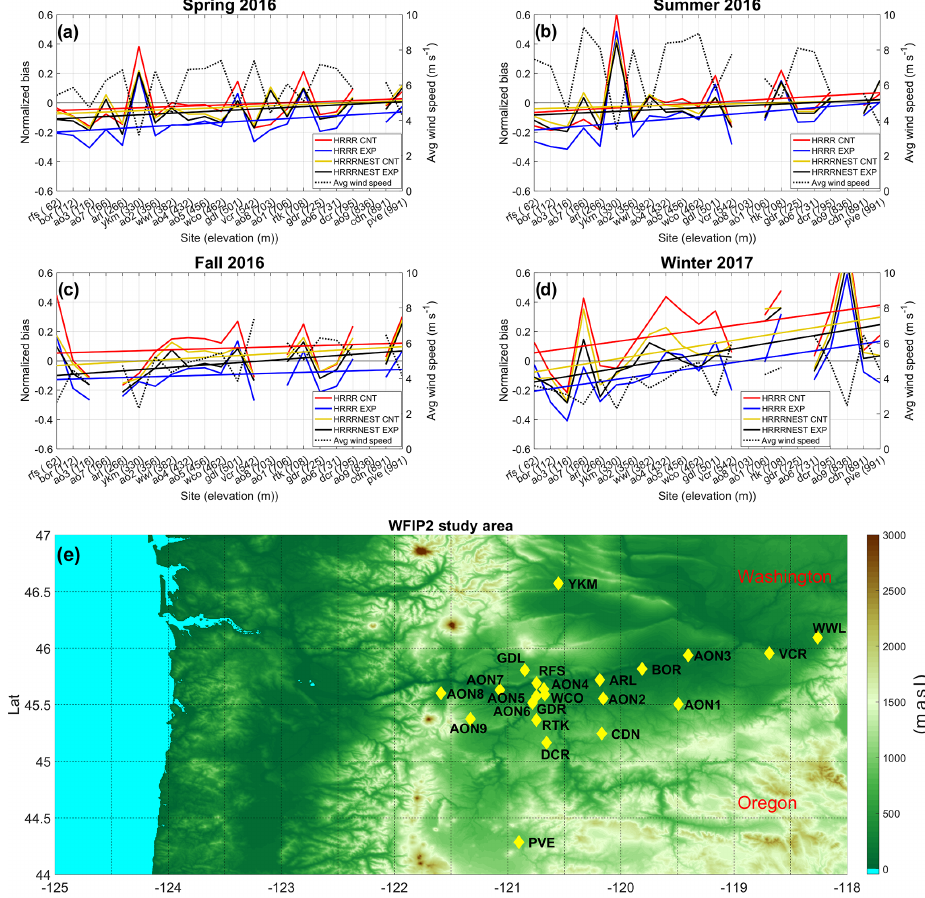
Figure 4. Eighty-meter wind speed bias (model–observations) normalized by the averaged (observed, in dotted black lines) 80m wind speed at each site for the four reforecast runs as a function of site elevation for the four reforecast periods separately: panel (a) is for the spring 2016 reforecast period, (b) for summer 2016, (c) for fall 2016 and (d) for winter 2017). Sites are sorted from low to high elevation (from Rufus at 62ma.s.l. to Prineville at 991ma.s.l.). Panel (e) : topography of the area and location of the